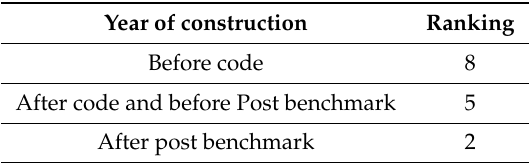
Table 7. ‘Code parameter’ rankings considered in MCDM methods.